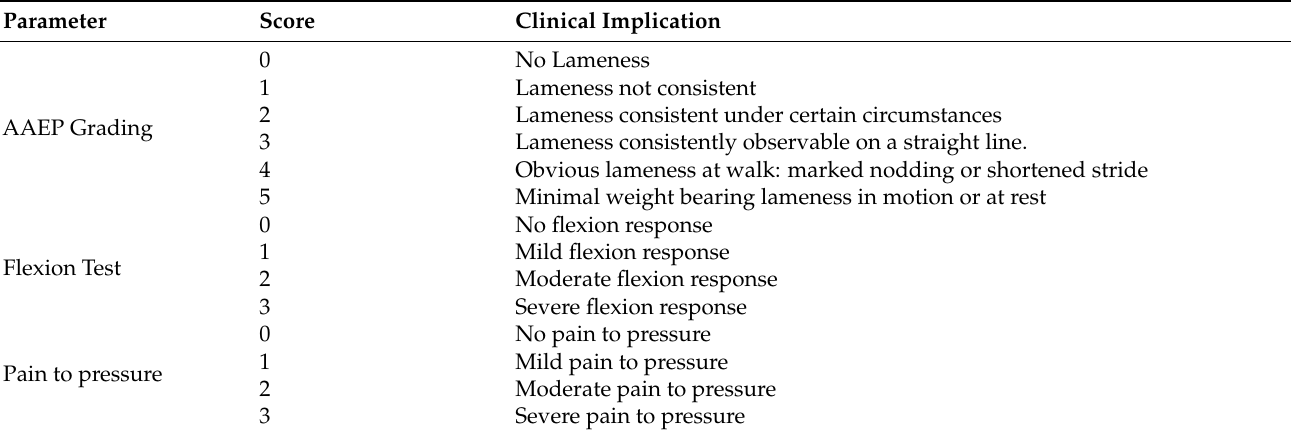
Table 1. Score systems used by the veterinary surgeon to assess lameness, and responses to flexion and pain to pressure tests